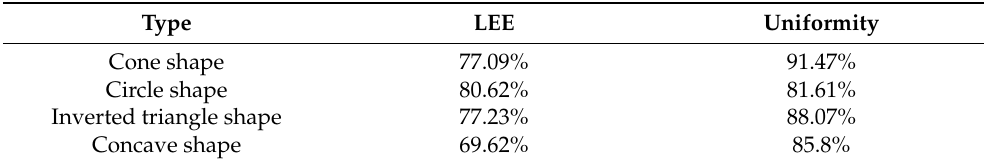
Table 2. Comparison of the LEE and spatial illuminance uniformity for different light coupling